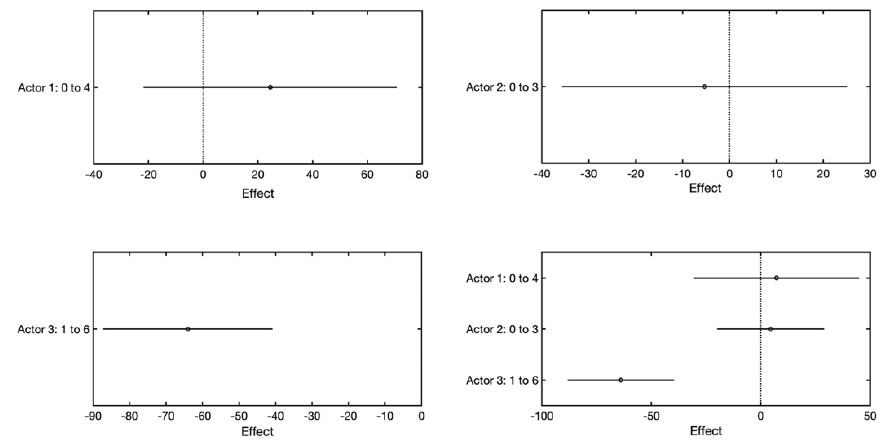
Figure 8. Comparison of the effects of individual actors.